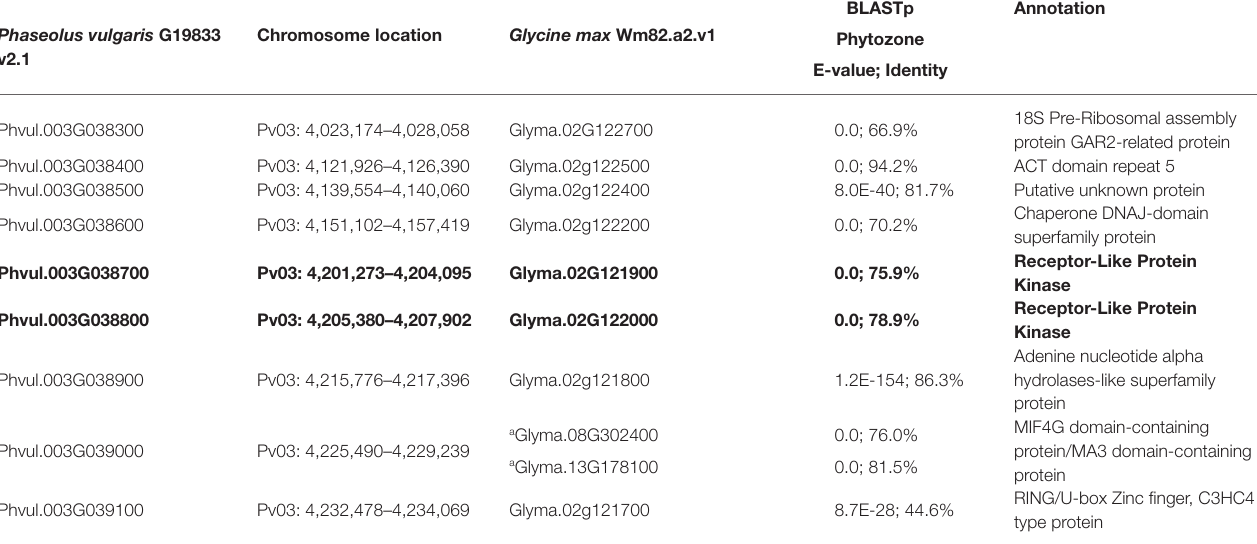
TABLE 3 | Synteny analysis between common bean and soybean comparing bc-1 and Rsv4 candidate genes (bold type), respectively.